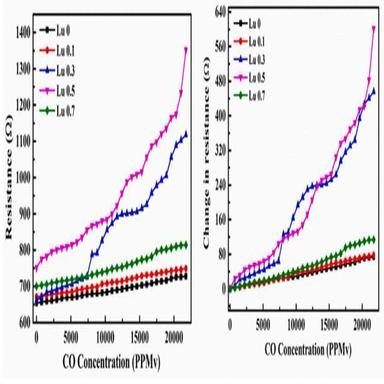
(a) Resistance v/s CO concentrations and (b) change in resistance of ZnFe(2-x)LuxO4, where x = 0.01(Lu 0.01), 0.03(Lu 0.03), 0.05(Lu 0.05), 0.07(Lu 0.07).